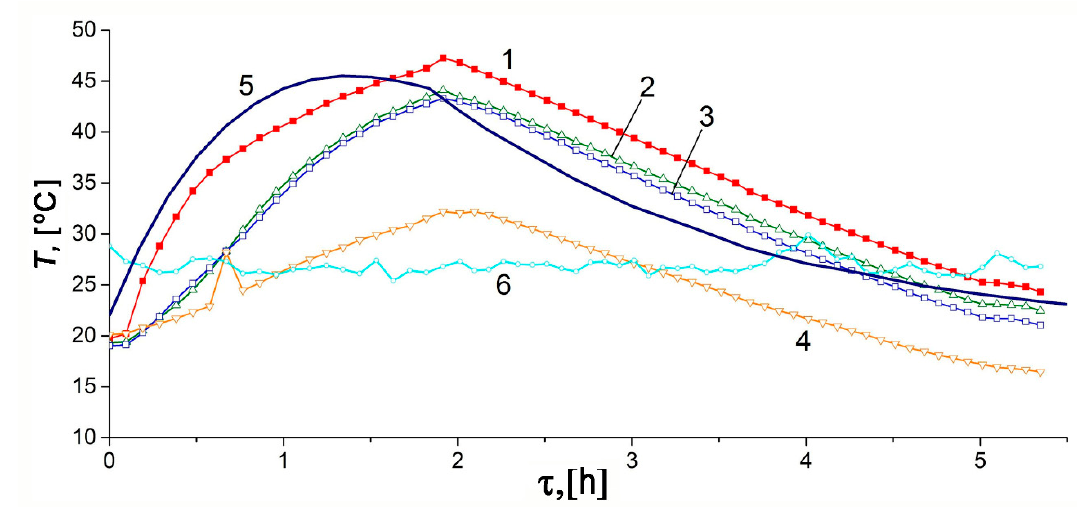
Figure 14. Temporal variations of the temperature inside and outside the ANG tank during the thermally regulated charge cycle: curves 1–4 correspond to the TE1–4 sensor readings, respectively; curve 5 is the average adsorber temperature calculated from the model, curve 6 is the ambient temperature. The average coolant temperature is 20 ◦